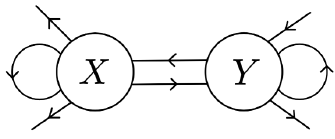
Figure 7 . Interactions of M5 giant graviton branes det X and det Y